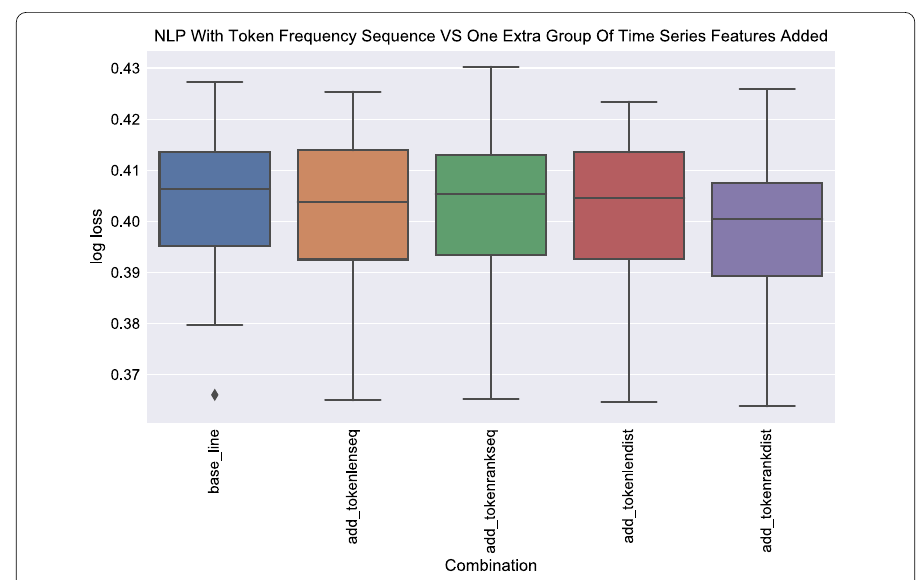
Figure 10 Box plots of the evaluation results of the third iteration, for the baseline (NLP combined with token frequency sequence) and with one extra time series features group added